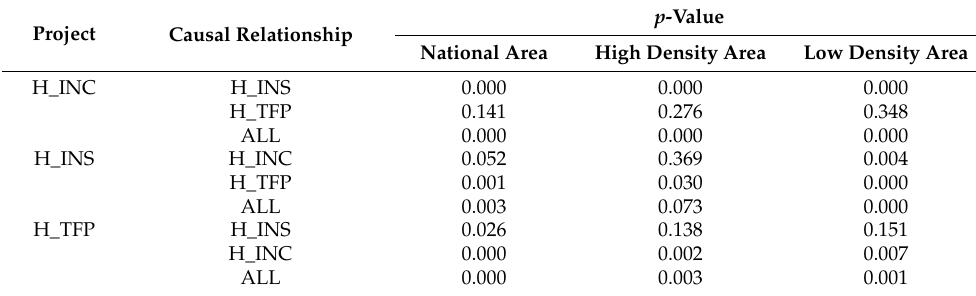
Table 5. Granger causality test.